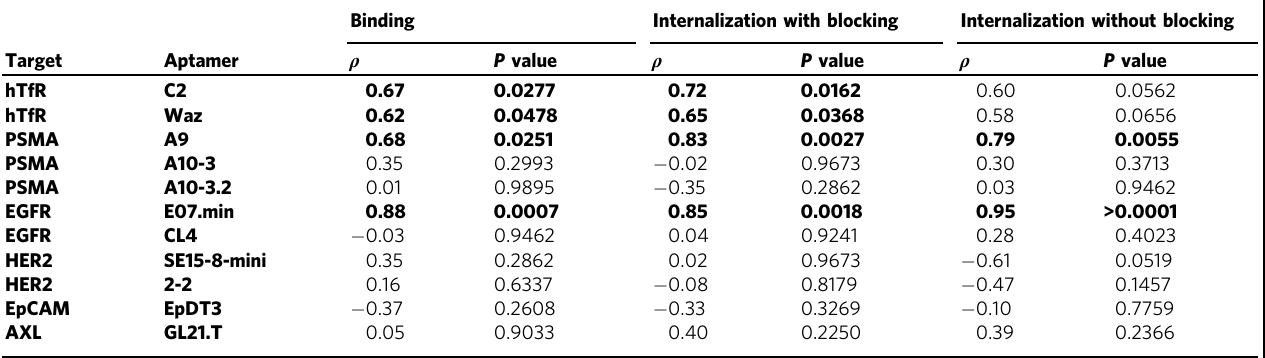
Table 3 Correlative analysis of aptamer and antibody binding.